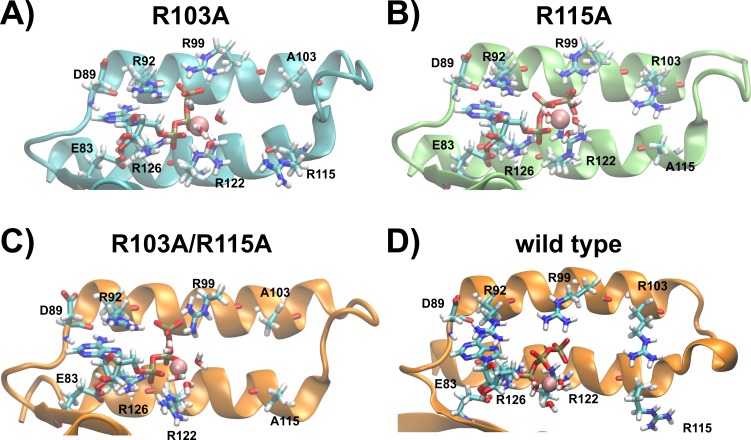
Predicted binding sites of the R103A and R115A mutants of the ε subunit from thermophilic Bacillus PS3.Zoom into the predicted binding site structures of the R103A, R115A R103A/R115A (Krah, Kato-Yamada & Takada, 2017) mutants and the wild type (Krah & Takada, 2016) of the ε subunit from thermophilic Bacillus PS3 are shown in (A), (B), (C) and (D), respectively. The protein is represented in cartoon format, with critical residues and bound Mg2+ATP shown in licorice format and labelled. (A) and (B) were rendered using VMD (Humphrey, Dalke & Schulten, 1996), while (C) and (D) were adapted from our previous work (Krah, Kato-Yamada & Takada, 2017). The predicted binding site structures of the R103A and R115A mutants when Mg2+ is bound to ATP:Oβ/Oγ are shown in Fig. S6.